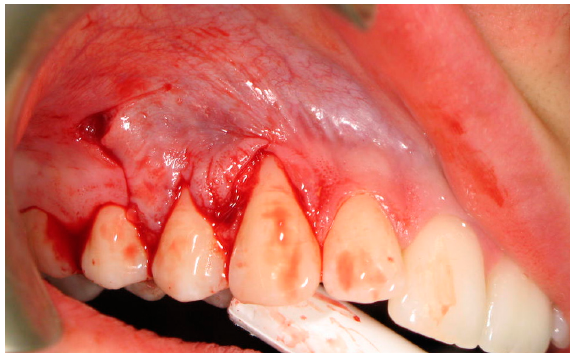
Figure 4. Surgical incisions for flap preparation.